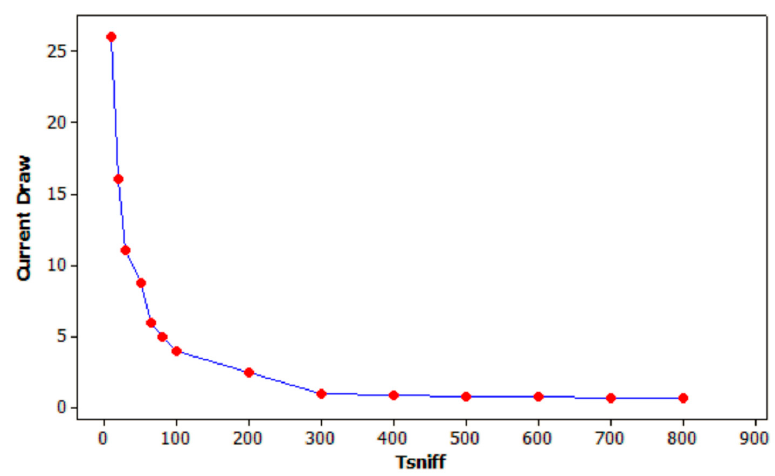
Figure 8. Current consumption vs. inactivity interval in sniff mode, T sniff .